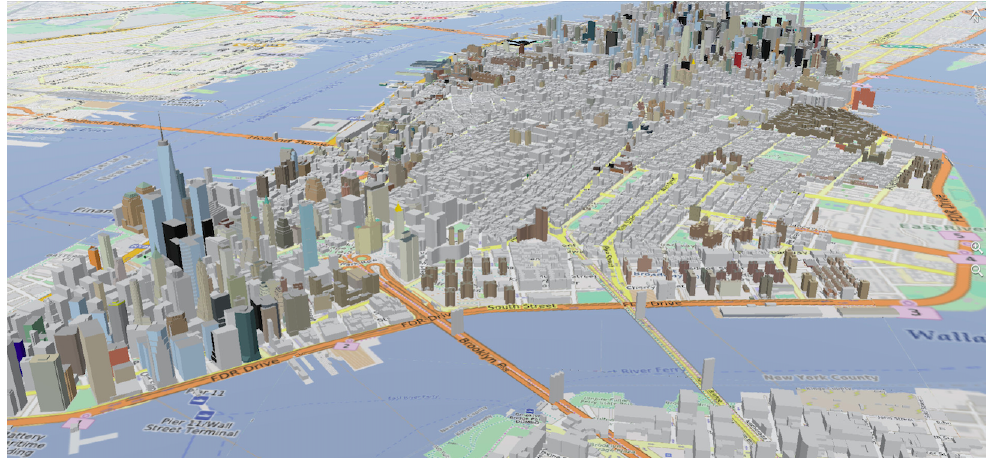
Figure 12. A 3D map of Manhattan Island, as defined in Open Street Map (OSM). Each building is stored as a 3D shape, allowing us to compute the associated visibility